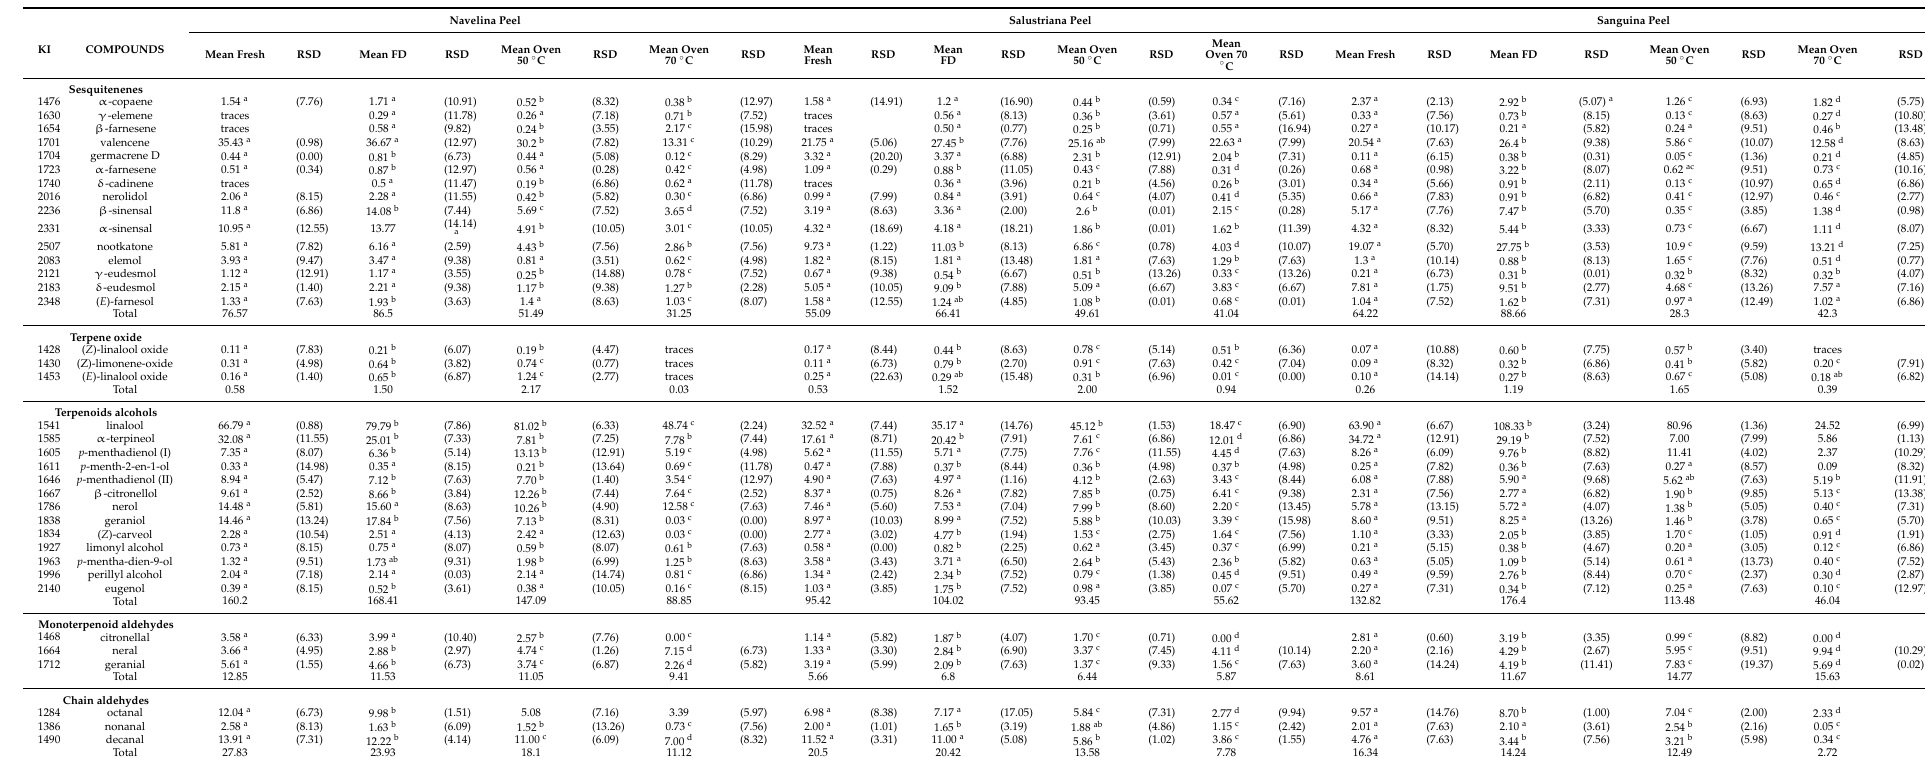
Table 1. Mean Concentration ( µ g. g − 1 DW) and relative standard deviation (%) of volatile compounds in citrus peel extracts from Navelina ( Citrus sinensis L. Osbeck cv. “Navelina”), Salustriana ( Citrus sinensis L. Osbeck cv. “Salustriana”), and Sanguina ( Citrus x sinensis var. “Sanguina”), fresh, oven-dried (50 ◦ C, 70 ◦ C), and freeze-dried